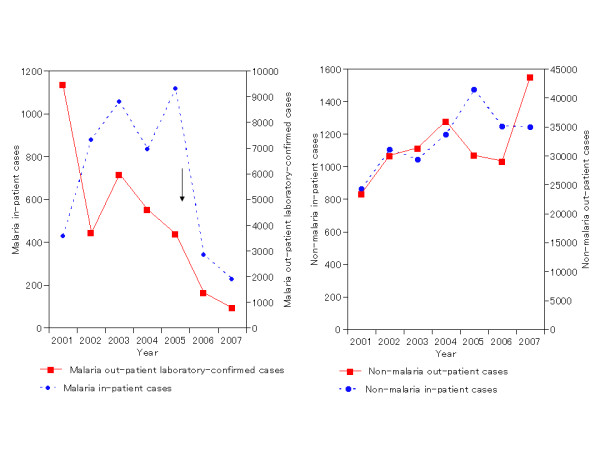
Malaria and non-malaria in- and out-patient cases, children < 5 years old, January to October 2001–2007, Ethiopia. LLIN = long-lasting insecticidal nets, ACT = artemisinin-based combination therapy medicines.